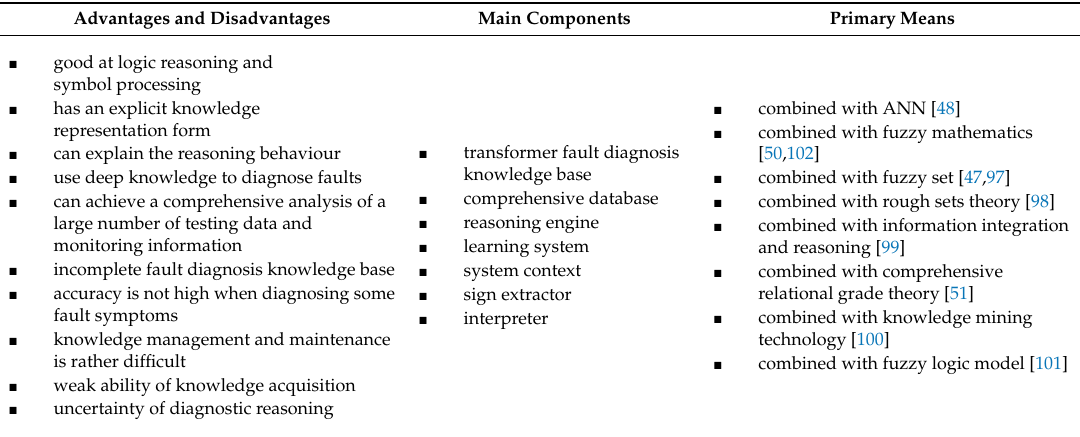
Table 5. A summary for the application of EPS in DGA based transformer fault diagnosis. Advantages and Disadvantages Main Components Primary Means good at logic reasoning and symbol